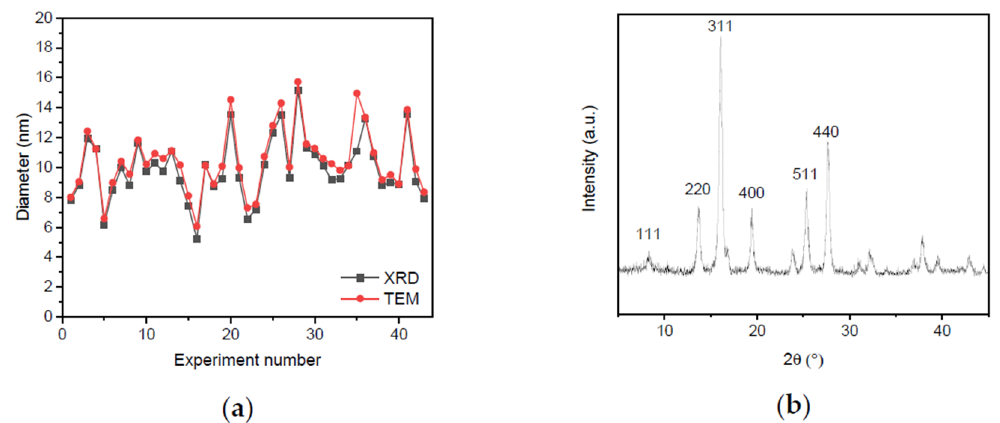
Figure 1. The diameters obtained from TEM and XRD analysis are compared for each experiment (a) . Diffractogram of sample 21, which illustrates the reflexes which can be found for spinel structures such as Fe 3 O 4 and γ-Fe 2 O 3 and a reflection broadening corresponding to 9.3 nm (b) . The reflections are indicated with Miller indices.